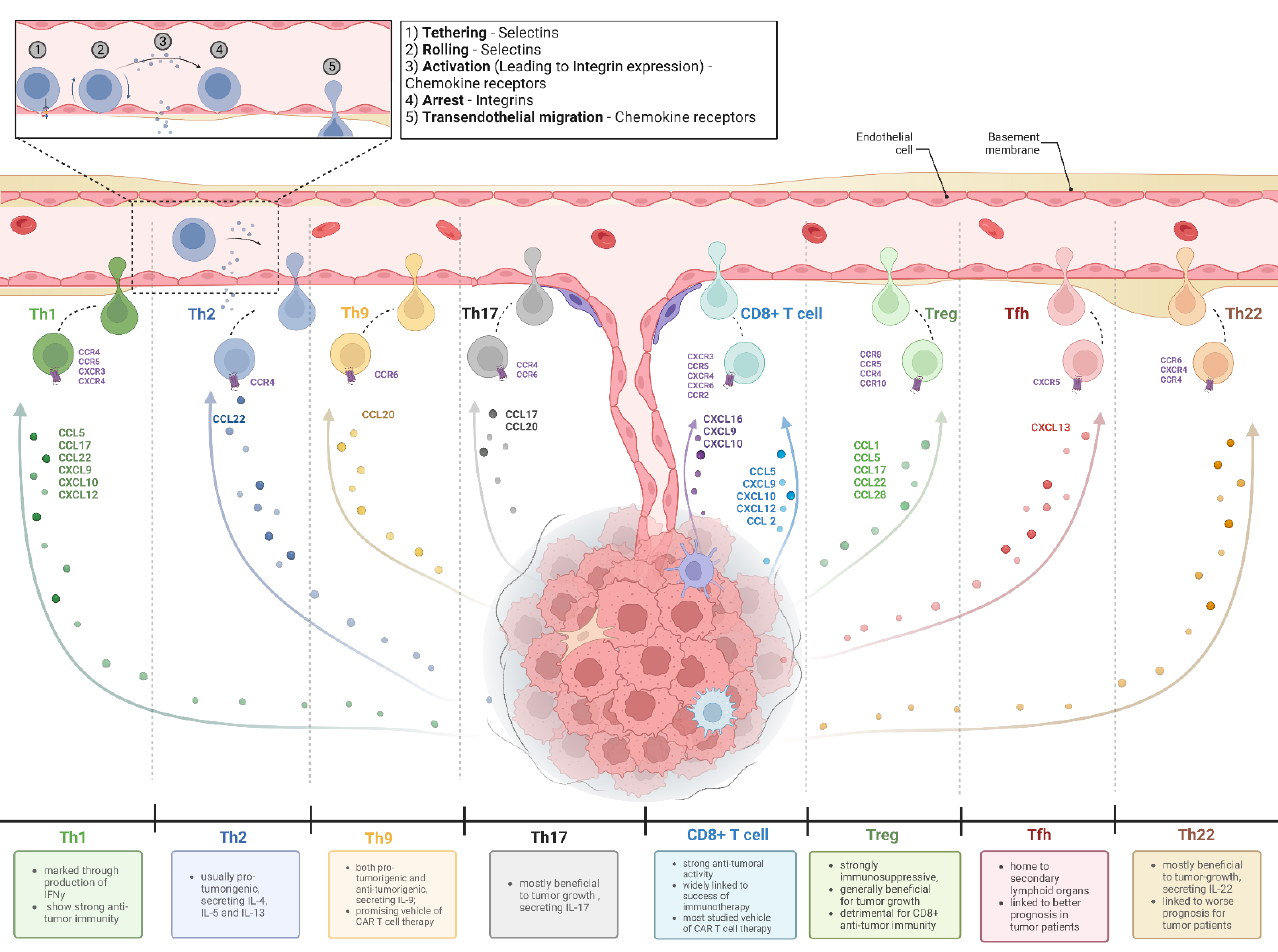
Figure 1. T cell migration into human tumors. Depicted are various T cell subsets which are found in solid tumors, as well as the impact each subset is regarded to have on tumor growth. To attract each T cell subset, tumors and/or cells of the TME secret a different set of chemokines which, as shown here, interacts with specific chemokine receptors, recruiting corresponding cells. The indicated chemokine–chemokine receptor interactions required for recruitment of each cell subset have been identified out of literature [26,28,45–54] and apply to different entities. Impact on tumor progression has been adapted from elsewhere [41,55,56]. Abbreviations: Th: T helper cell (correspondingly 1, 2, 9, 17, 22); Tfh: T follicular helper cell; Treg: regulatory T cell. Figure created with BioRender.com. Adapted from “Tumor Vascularization”, by BioRender.com (2022). Retrieved from https://app.biorender.com/biorender-templates (accessed on 29 September